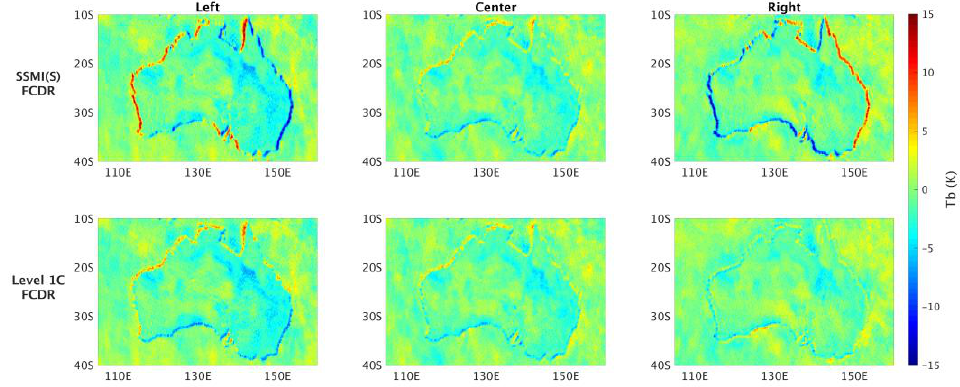
Figure 5. F10 19v ascending minus descending gridded Tb for the SSMI(S) FCDR dataset ( Top panels ) versus the Level 1C dataset ( Bottom panels ). The SSMI scan is divided into left, center, and right subsets to show differences. The SSMI(S) FCDR dataset shows a significant change between the left and right sides of the scan indicating the attitude is incorrect, while the Level 1C dataset shows a consistent pattern across the